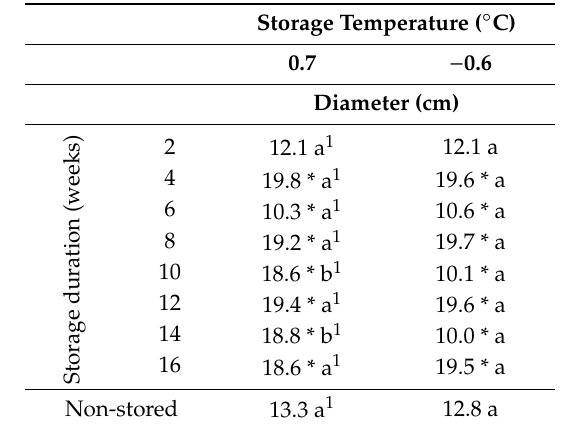
Table 4. Mean flower diameter (cm) for Paeonia lactiflora cultivar Sarah Bernhardt (SB) in response to storage temperature and storage duration in Exp2 independent of pre-storage